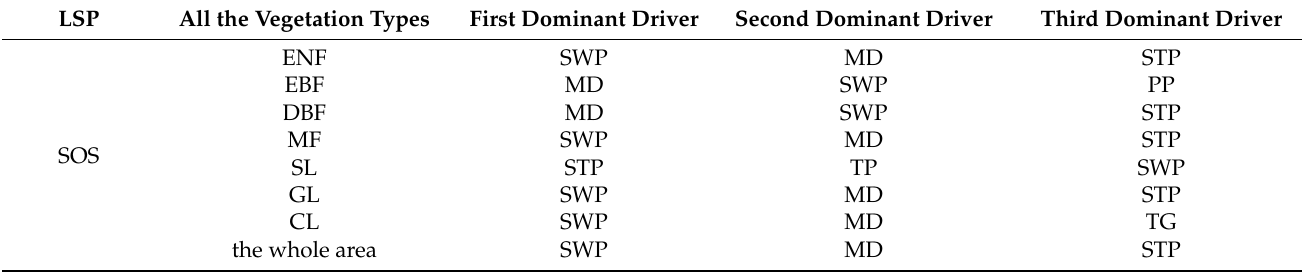
Table 6. The top three dominant drivers affecting interannual variations in LSP. These three dominant factors are derived from the ranking of the importance scores of the variables (VI). Different vegetation types have different dominant drivers. LSP All the Vegetation Types First Dominant Driver Second Dominant Driver Third Dominant Driver